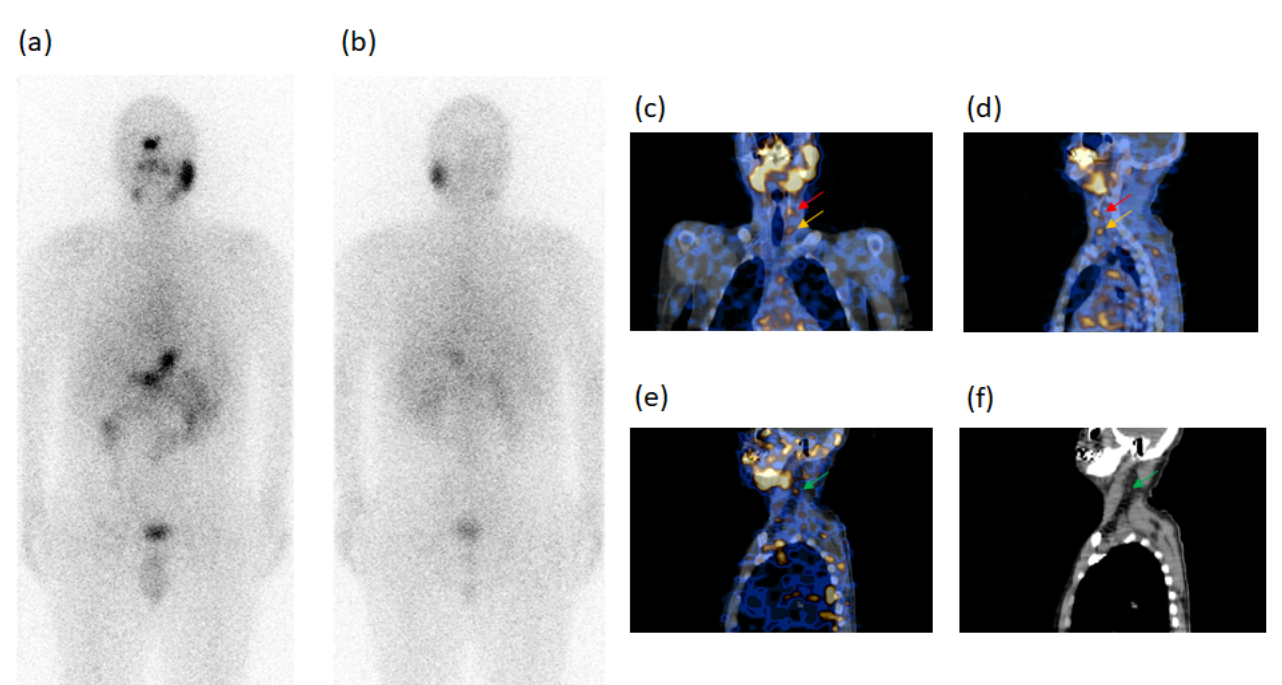
Figure 3. The same patient described in Figure 2 (case n. 2, Table 3) was re-evaluated in the follow-up. WBS in both anterior ( a ) and posterior ( b ) views did not show any radioiodine avid foci to consider as residues or malignant lesions. Fused SPECT/CT images in coronal ( c ) and left ( d ) and right sagittal ( e ) views excluded the two malignant foci evidenced in basal condition. However, it identified three new foci, two of which in the left laterocervical region (red and yellow arrows) and another in right laterocervical region, the latter better evidenced in sagittal right view (green arrow) and confirmed by CT ( f ). These foci were classified as lymph node metastases in disease progression. The patient was treated again with a therapeutic dose of radioiodine. Thyroglobulin levels in hypothyroidism condition: 36 ng/mL. AbTg: absent.